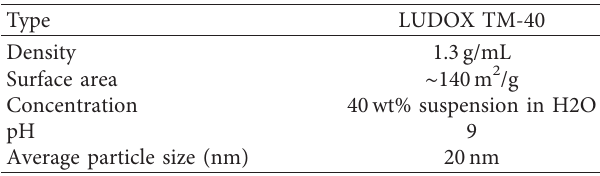
Table 2: Properties of colloidal